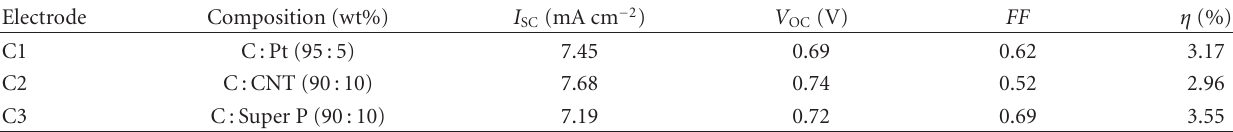
Figure 1: Schematic diagrams of (a) Pt, (b) CNTs, and (c) CB coated on MCMB powders. Table 1: Parameters for solar cells based on di ff erent carbon counter